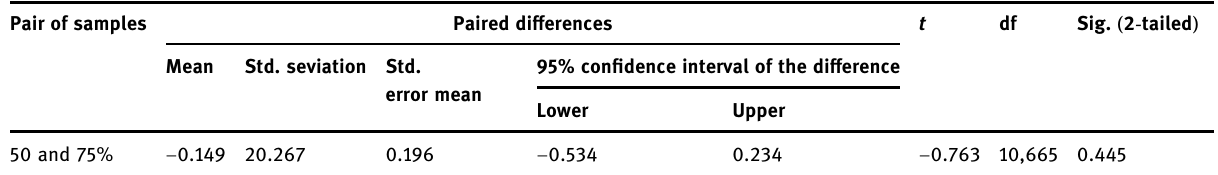
Table 2: Paired samples T - test Pair of samples